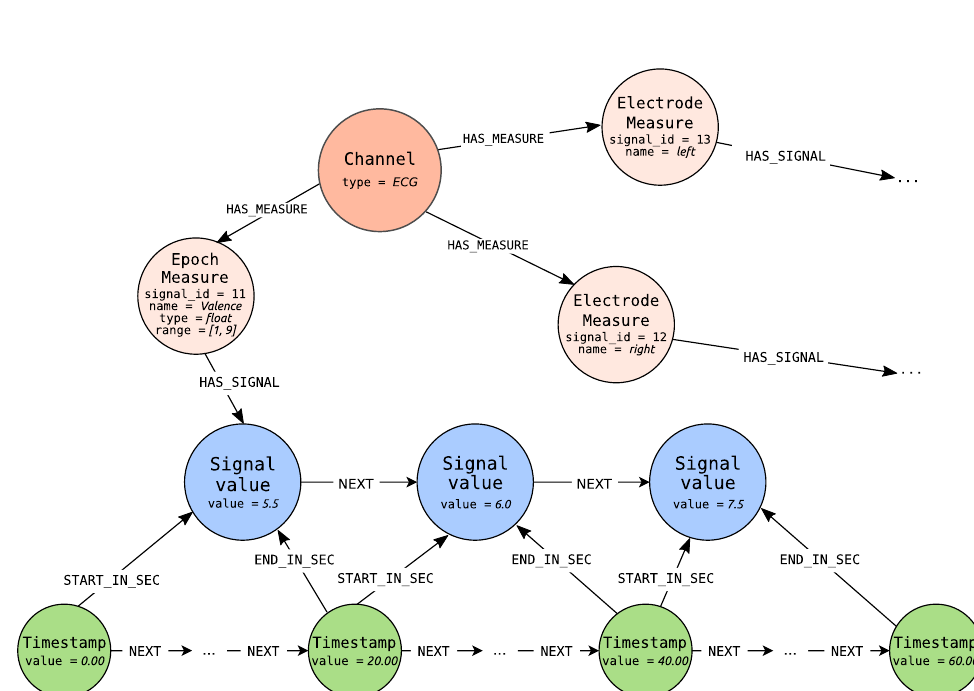
Figure 7. Constant epoch-length signal representing measured valence